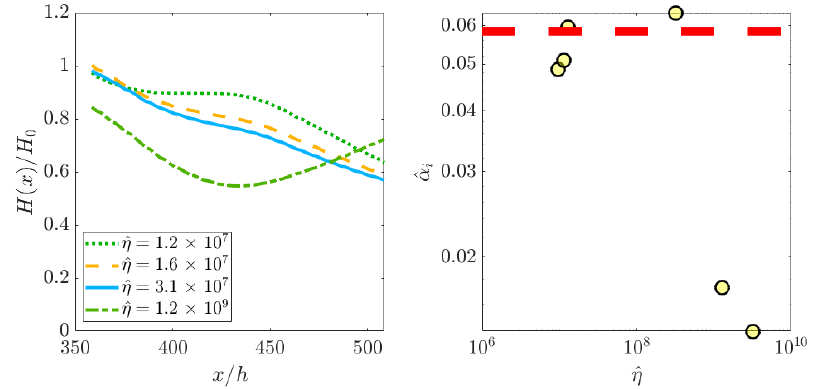
Figure 13. Effects of dynamic viscosity on the wave decay along an ice cover. Left panel shows the wave decay over the length of the cover, and right panel shows the computed attenuation rates (found through exponential curve fitting). The horizontal line refers to the value reported in experiments of Yiew et al. [53].